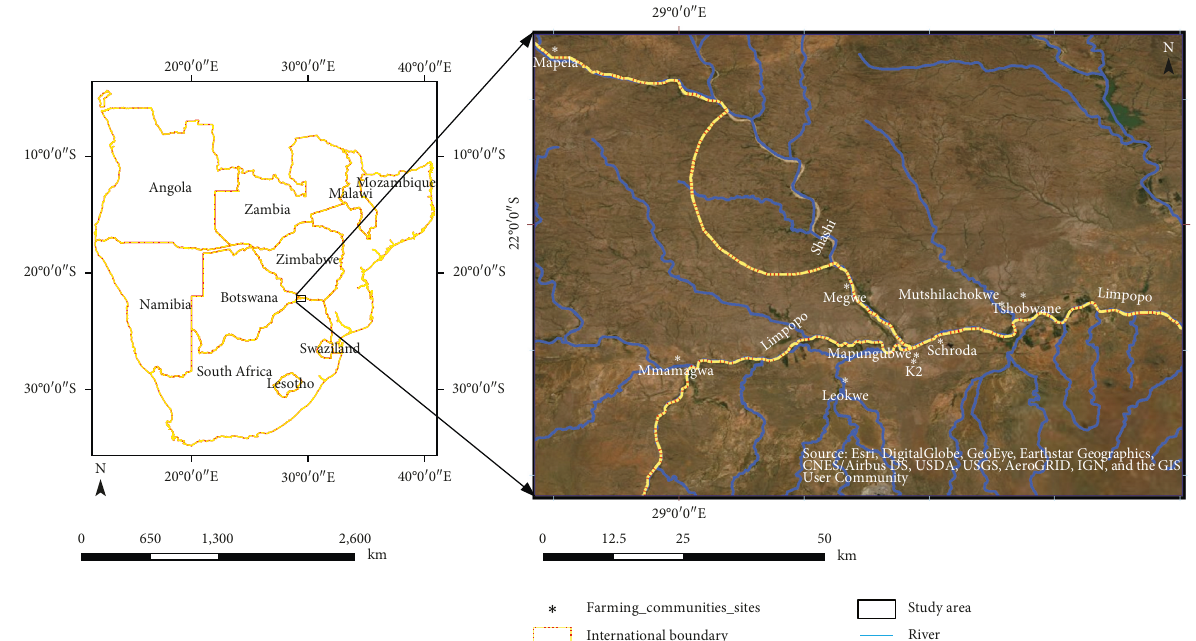
Figure 1: Location of the SLCA in southern Africa with some of the major farming communities sites mentioned in the text.